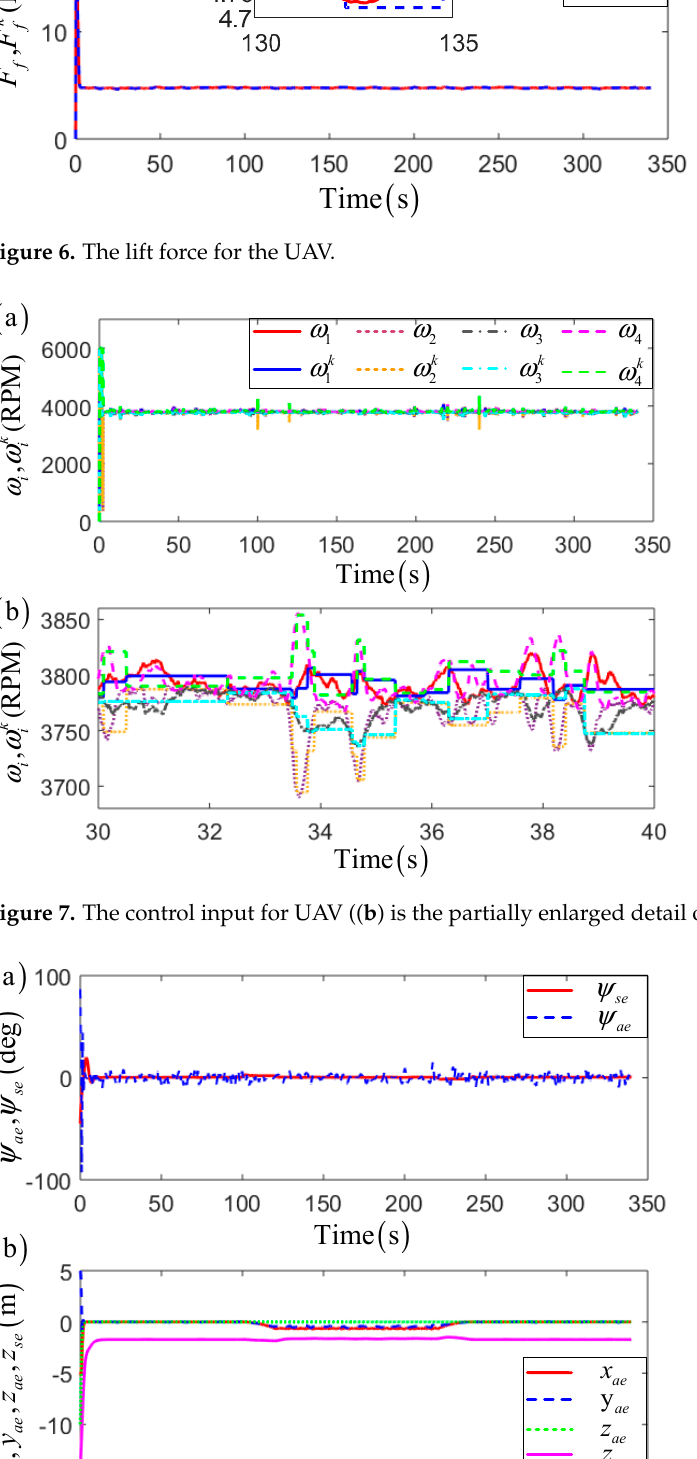
( ) Time s Figure 9. The adaptive parameters for the USV-UAV (( a ) is adaptive parameters for USV. ( b ) is adaptive parameters for UAV.).